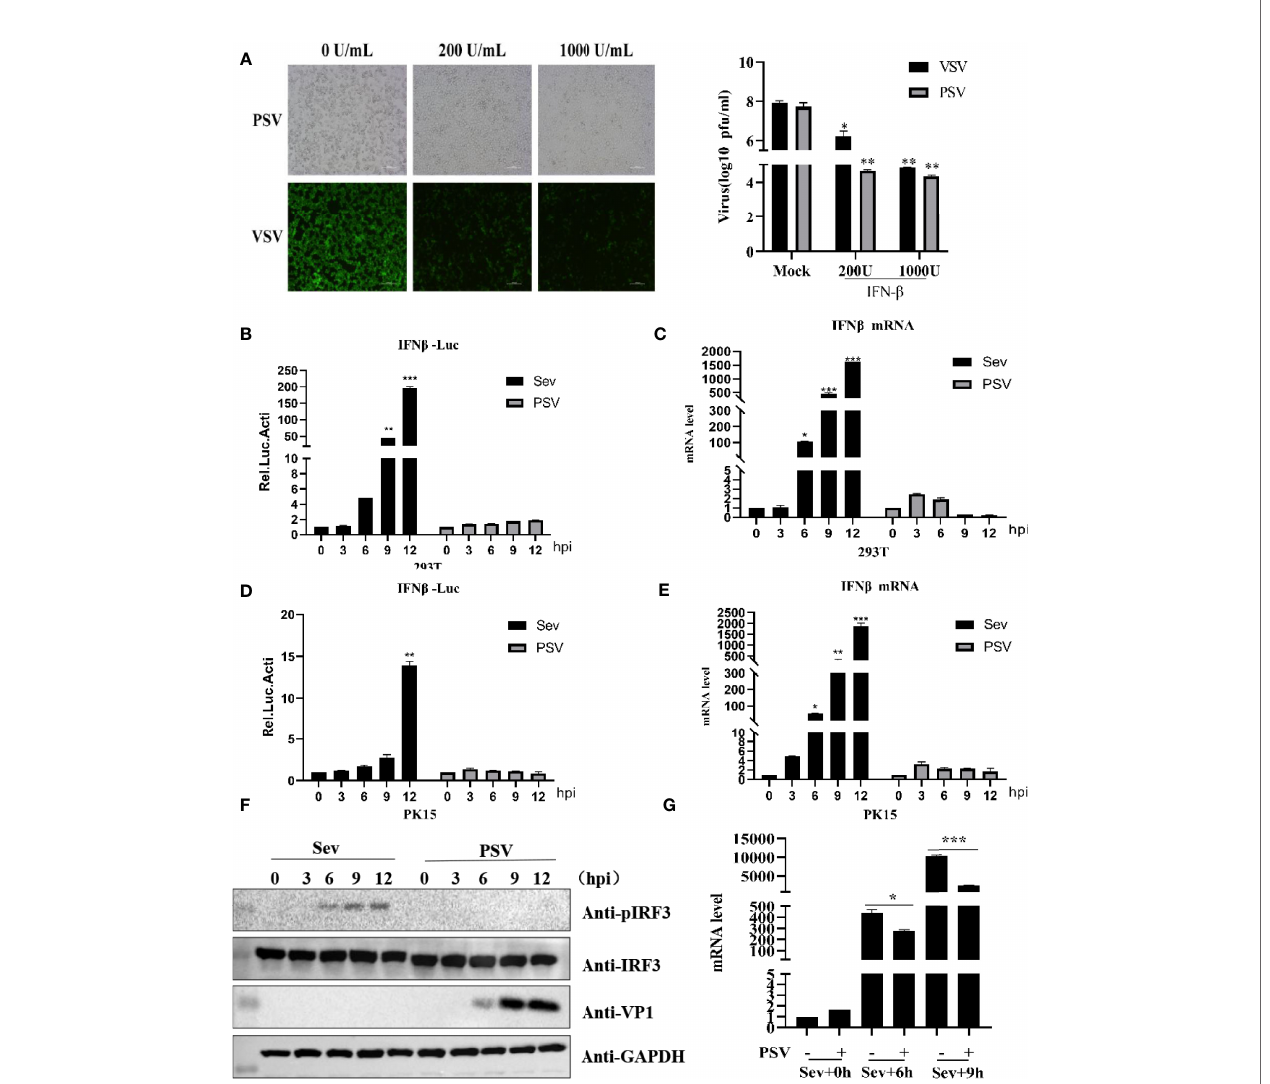
FIGURE 1 | PSV infection inhibits host type I IFN production. (A) HEK293T cells were seeded in 12-well plates, and the monolayer cells were pretreated with IFN- b at the indicated concentration for 12 h. Then the cells were infected with VSV-GFP (0.1 MOI) or SVV (0.01 MOI) for 24 h. The CPE was observed in microscopy. Virus titer was determined by plaque assay. (B) HEK293T cells were seeded in twenty-four-well plates, and the monolayer cells were co-transfected with 100 ng IFN- b reporter and 5 ng pRL-TK (as an internal control) plasmids for 20 h. Then the cells were infected with Sev (25 HA) or PSV (0.1 MOI) or not for the indicated times. The cells were then subjected to dual-luciferase assays at 12 h postinfection (hpi). (C) HEK293T cells were seeded in 24-well plates, and the monolayer cells were infected with Sev (25 HA) or PSV (0.1 MOI) or not for the indicated times. The mRNA expression level of IFN- b was evaluated with qPCR assay, and housekeeping gene GAPDH was used as the control. (D) PK15 cells were seeded in 24-well plates, and the monolayer cells were co-transfected with 200 ng IFN- b reporter and 5 ng pRL-TK (as an internal control) plasmids for 20 h. Then the cells were infected with Sev (25 HA) or PSV (0.1 MOI) or not for the indicated times. The cells were then subjected to dual-luciferase assays at 12 h postinfection (hpi). (E) PK15 cells were seeded in 24-well plates, and the monolayer cells were infected with Sev (25 HA) or PSV (0.1 MOI) or not for the indicated times. The mRNA expression level of IFN- b was evaluated with qPCR assays, and housekeeping gene GAPDH was used as the control. (F) HEK293T cells were seeded in 24-well plates, and the monolayer cells were infected with Sev (25 HA) or PSV (0.1 MOI) or not for the indicated times. The cells were collected for Western blotting. (G) HEK293T cells were seeded in 12-well plates, and the monolayer cells were infected with PSV (0.5 MOI) or not for 3 h, then infected or not with Sev (25 HA) for another 6 and 9 h. The mRNA expression level of IFN- b was evaluated with qPCR assays, and housekeeping gene GAPDH was used as the control. Data are represented. Student ’ s t-test: *P < 0.05, **P < 0.01, ***P <